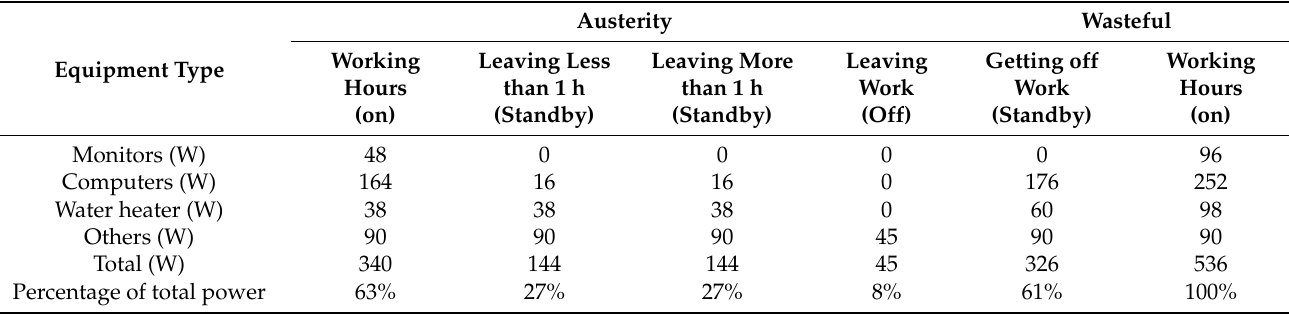
Figure 5. The power of each type of equipment for the austerity and wasteful behavior styles: ( a ) Austerity behavior style; ( b ) Wasteful behavior style. Table 6. The mean power of all equipment.